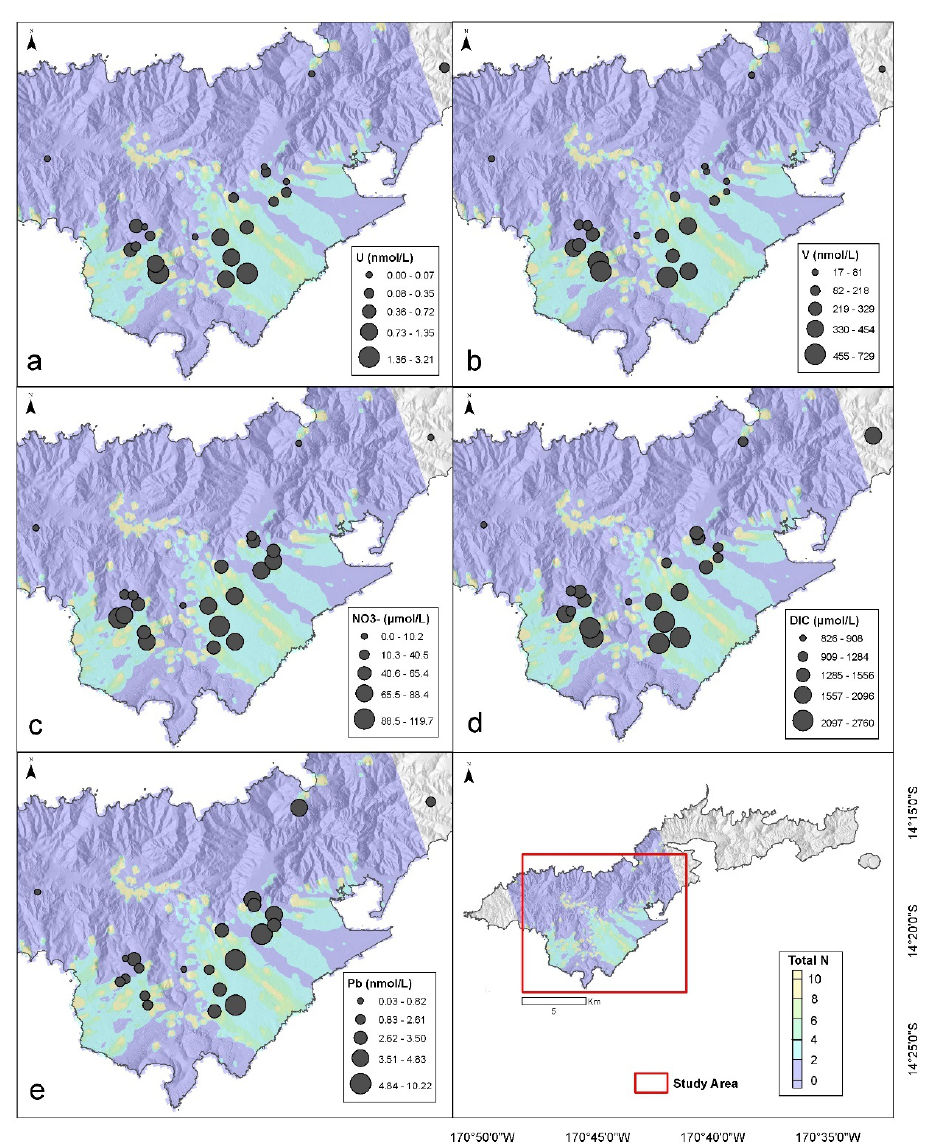
Figure 5. Spatial distribution of ( a ) U concentrations, ( b ) V concentrations, ( c ) NO 3 − concentrations, ( d ) DIC concentrations, and ( e ) Pb concentrations measured from groundwater across the Tafuna–Leone Plain, Tutuila, American Samoa. Concentrations are placed over a modeled total N distribution map modified from Shuler et al. [2]. Since the modeled total N distribution is a function of anthropogenic activities (OSDS, piggeries, agriculture) superimposed on groundwater flow calculations, this represents the areas that are either urbanized or downgradient of urbanization. Bottom right map displays the extent of maps ( a – e ), outlined by the red box. Data can be found in Table 1. The sample names associated with each sample location can be seen in Figure 2.